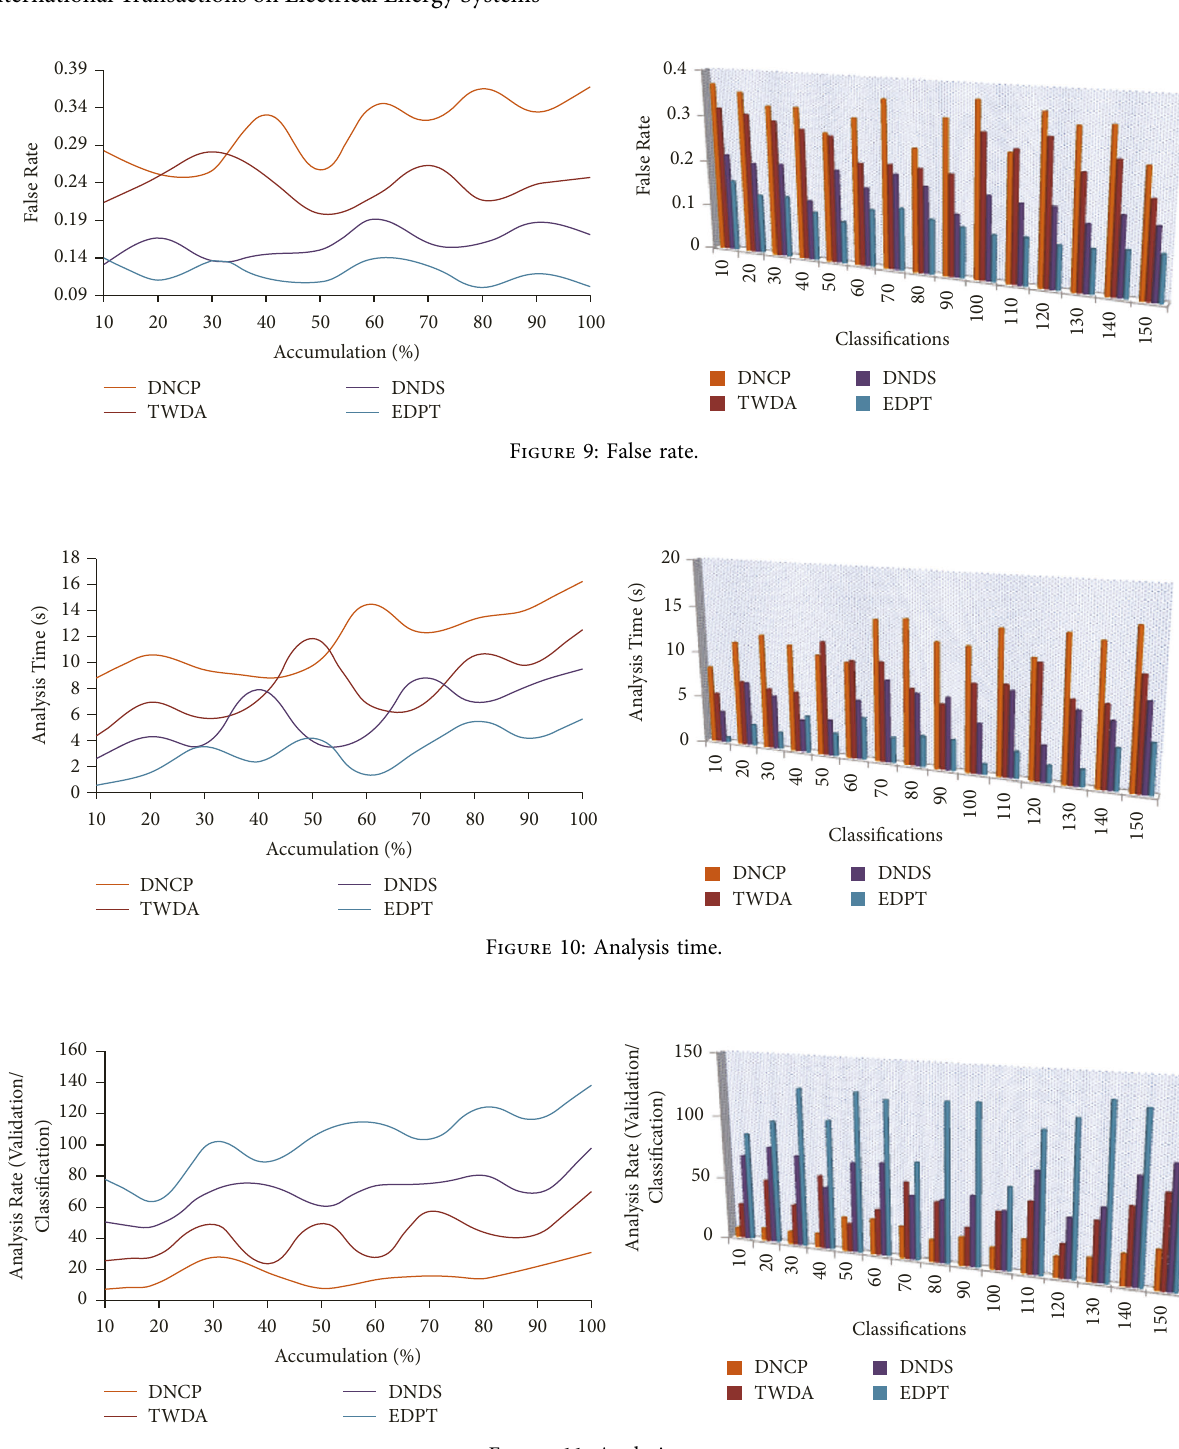
Figure 11: Analysis